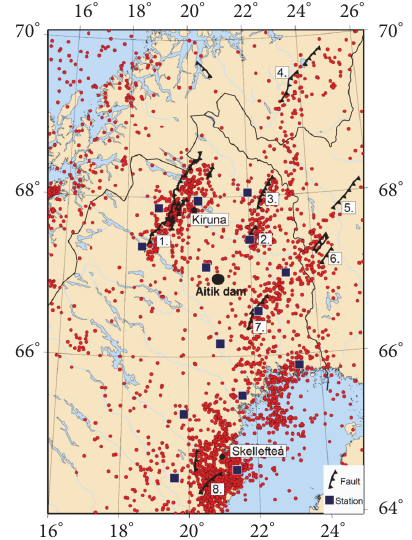
Figure 1: Observed earthquakes from year 1398 and onwards from the joint Nordic catalogue at Helsinki University FENCAT (2011) and from 2000–2011 by the Swedish National Seismic Network (SNSN) at Uppsala University (e.g., [2]). The location of the Aitik tailings dam is indicated by the circle. Red dots show the epicentral location of the earthquakes. Blue rectangles show the location of permanent Swedish seismic stations. Postglacial faults are highlighted by numbers: ( 1 ) the P¨arvie fault, ( 2 ) the Merasj¨arvi fault,( 3 )theLainio-Suijavaarafault,(4)theStuoragurrafault,(5)the Suasselka fault, (6) the Pasmaj¨arvi/Venej¨arvi fault, (7) the Lansj¨arv fault, and (8) the Burtr¨ask fault. Modified from